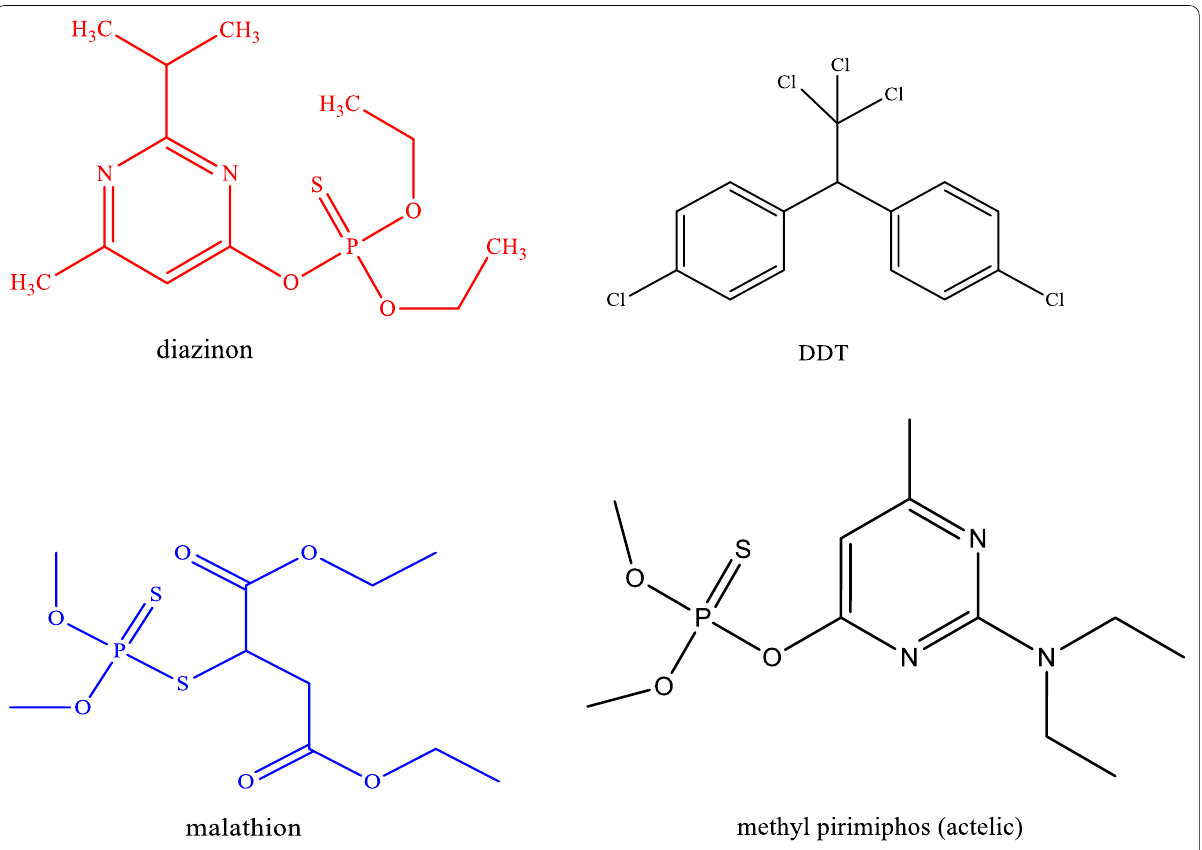
Fig. 3 Pesticides commonly used in Khat farming— adapted from Regassa and Regassa